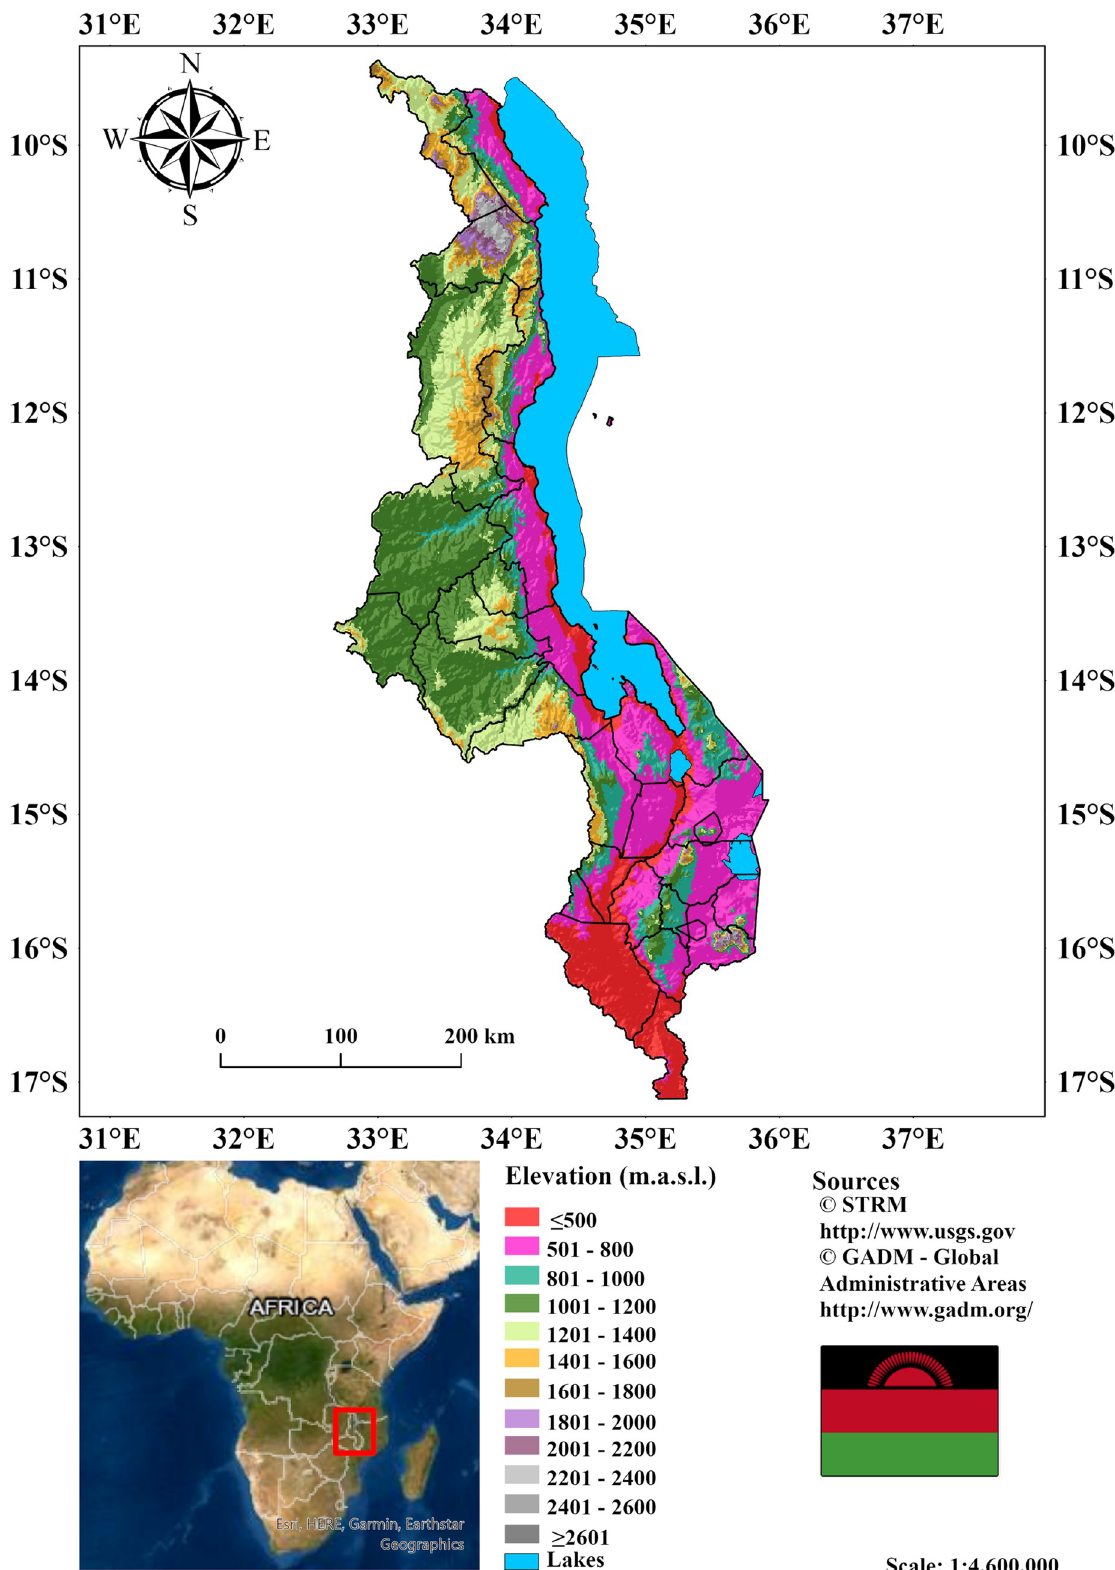
Fig 1. Geographic location and topography of Malawi based on Shuttle Radar Topography Mission digital elevation model data.